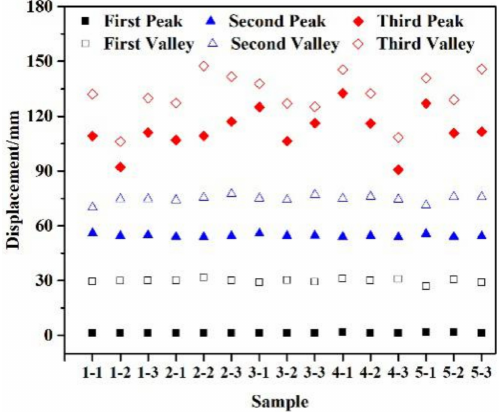
Figure 5. Displacement of the extreme points of the crushing